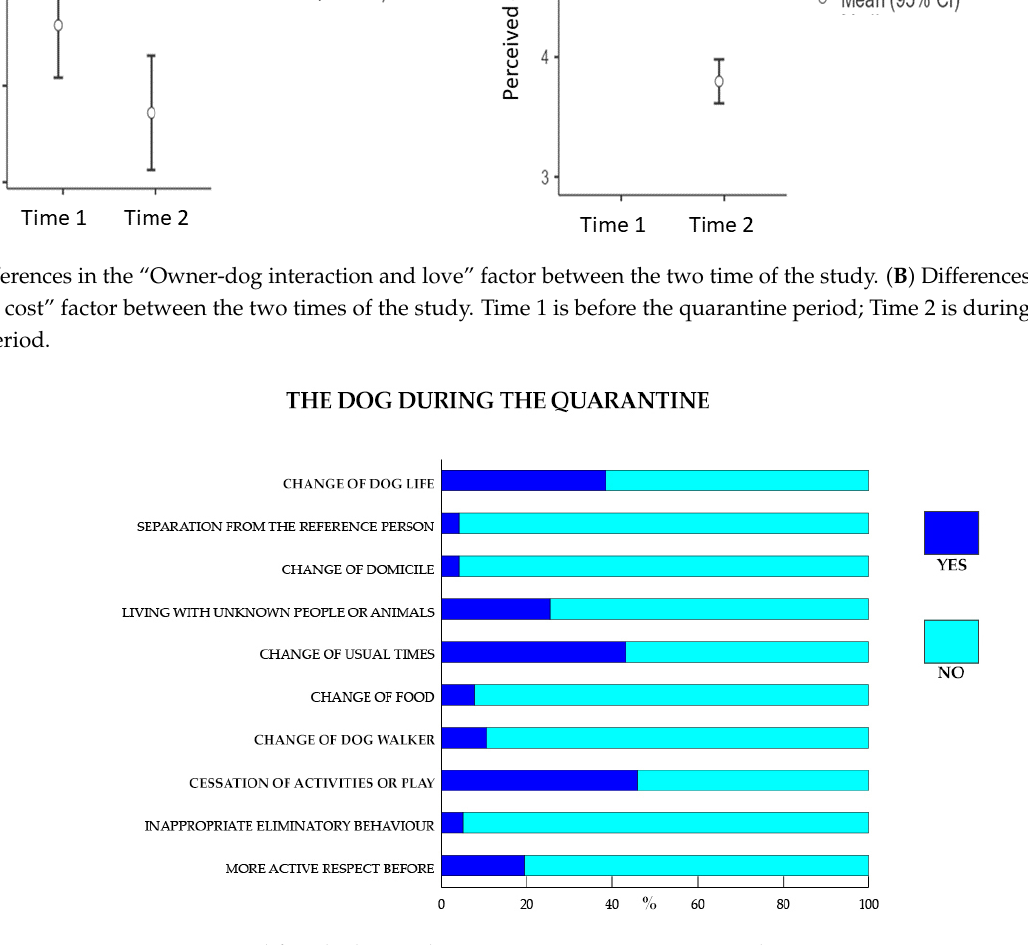
Figure 4. Dog’s lifestyle during the quarantine. Data are expressed in